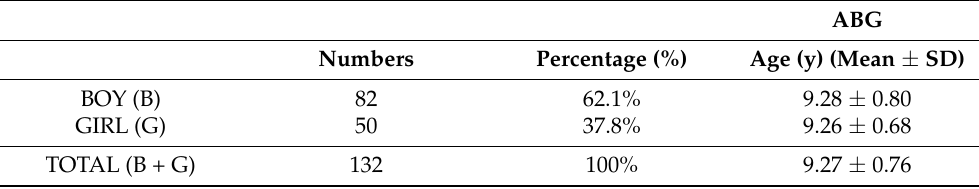
Table 1. Gender distribution and mean age undergoing alveolar bone graft (ABG).